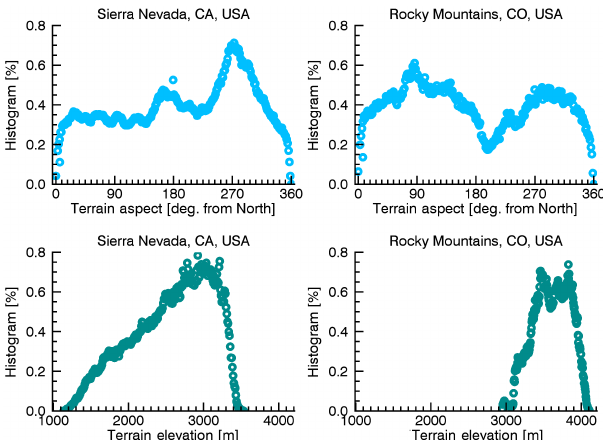
Figure 2. Histograms of the terrain aspect (top panels) and elevation (bottom panels) for the two study sites, Kings/Kaweah Basin, Sierra Nevada, CA (left panels), and Uncompahgre Basin, Rocky Moun- tains, CO (right panels). The values are normalized by the size of the study area given in Table 1. The peak occurrences of terrain aspect give an indication to the main drainage direction of a river